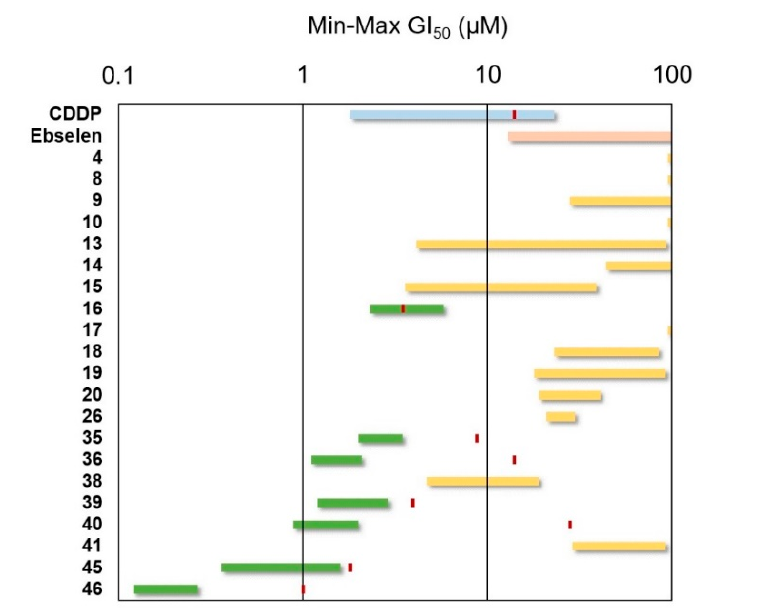
Figure 2. GI 50 range plot of active compounds against human solid tumor cell lines and GI 50 values against human fibroblasts (red bars). Cisplatin (CDDP) was used as reference anticancer drug. Ebselen was used as reference parental drug. Green colour indicates GI 50 < 10 µM for all cell lines. Yellow colour indicates GI 50 > 10 µM for some or all cell lines.